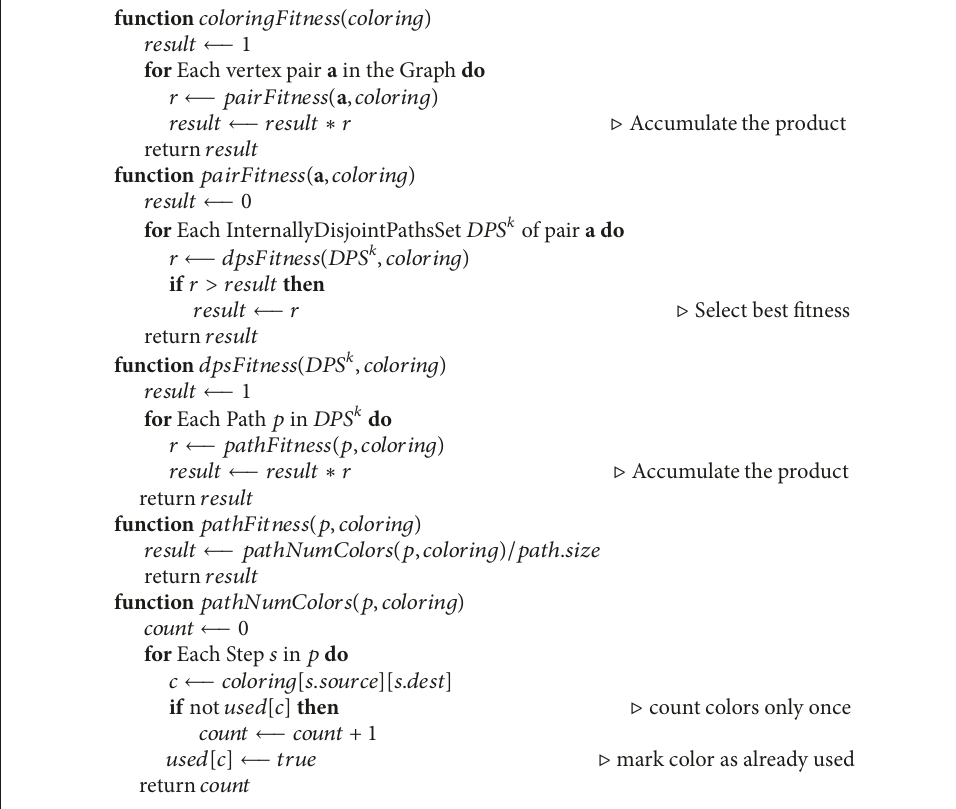
Algorithm 2: Coloring fitness